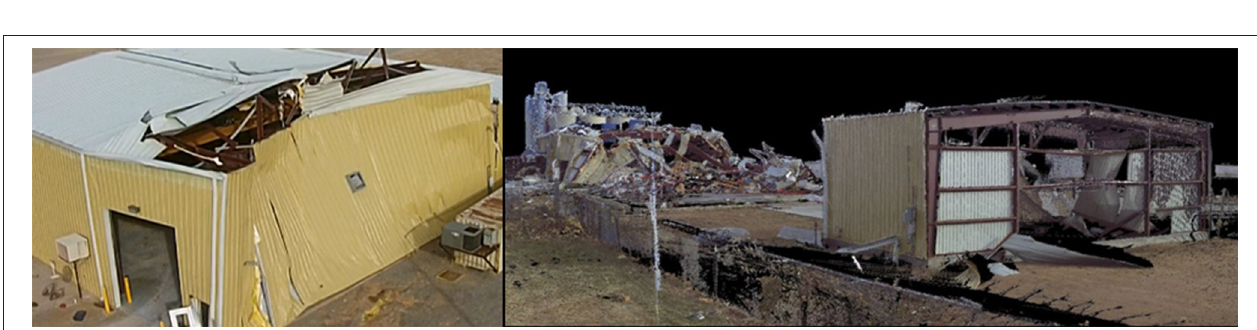
FIGURE 12 | Tornado damage to Wisner-Pilger Middle School: ground-survey image (Left) and point-cloud imagery derived from lidar and SfM (Right) , located at Pilger, NE. (Image Credit: R. L. Wood/M. E. Ebrahim Mohammadi).